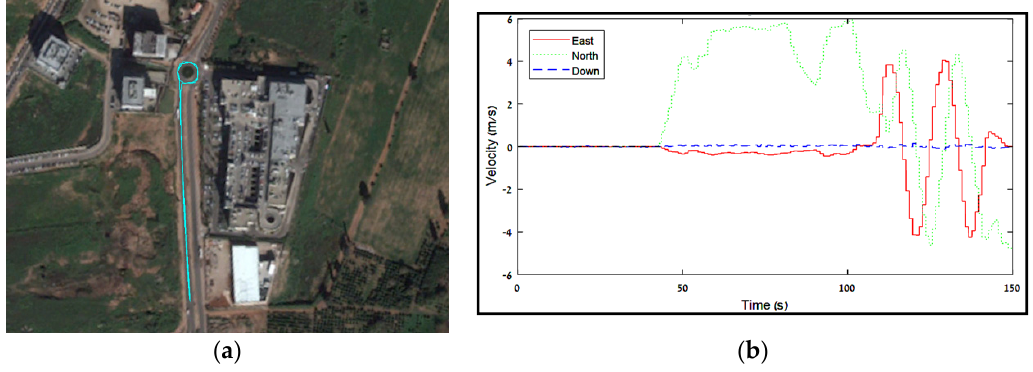
Figure 4. Field test properties. ( a ) Driving path; ( b ) Velocity extracted from the GNSS receiver.